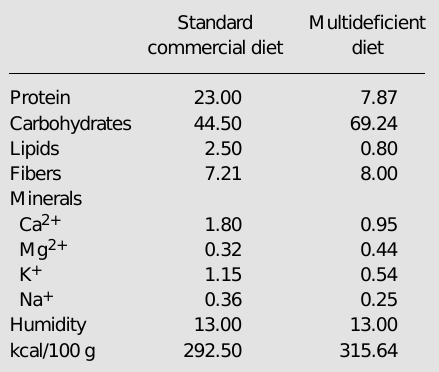
Table 1 - Composition (g/g%) of the multideficient synthetic and standard commercial diets. Composition determined from the cooked multi- deficient